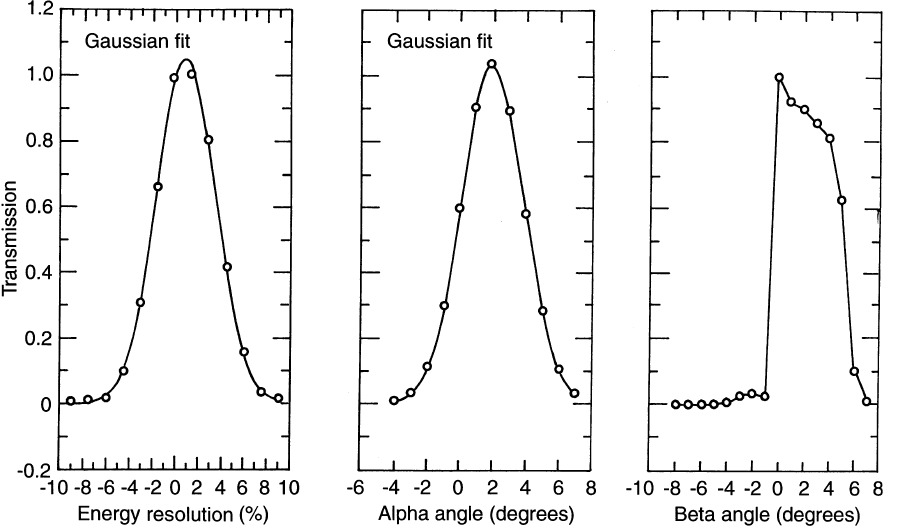
Fig. 4. Energy and angular resolu- tions of the electron detectors ION-3/ 4. The angle (cid:97) is measured in a plane perpendicular to the analyzer cylin- drical plates; (cid:98) is measured in a plane perpendicular